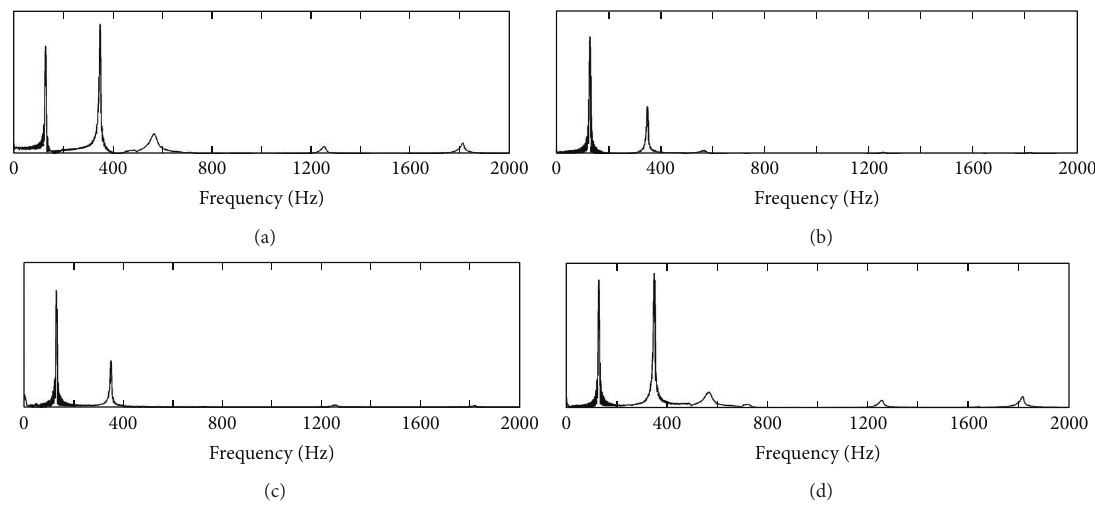
Figure 15: Spectrum displacement shown in Figure 14 on points (a) A, (b) B, (c) C, and (d)